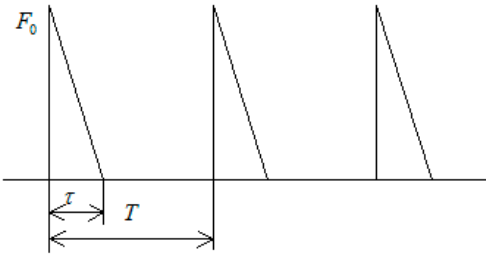
Figure 5. Simplified deterministic ice force model of a conical structure.